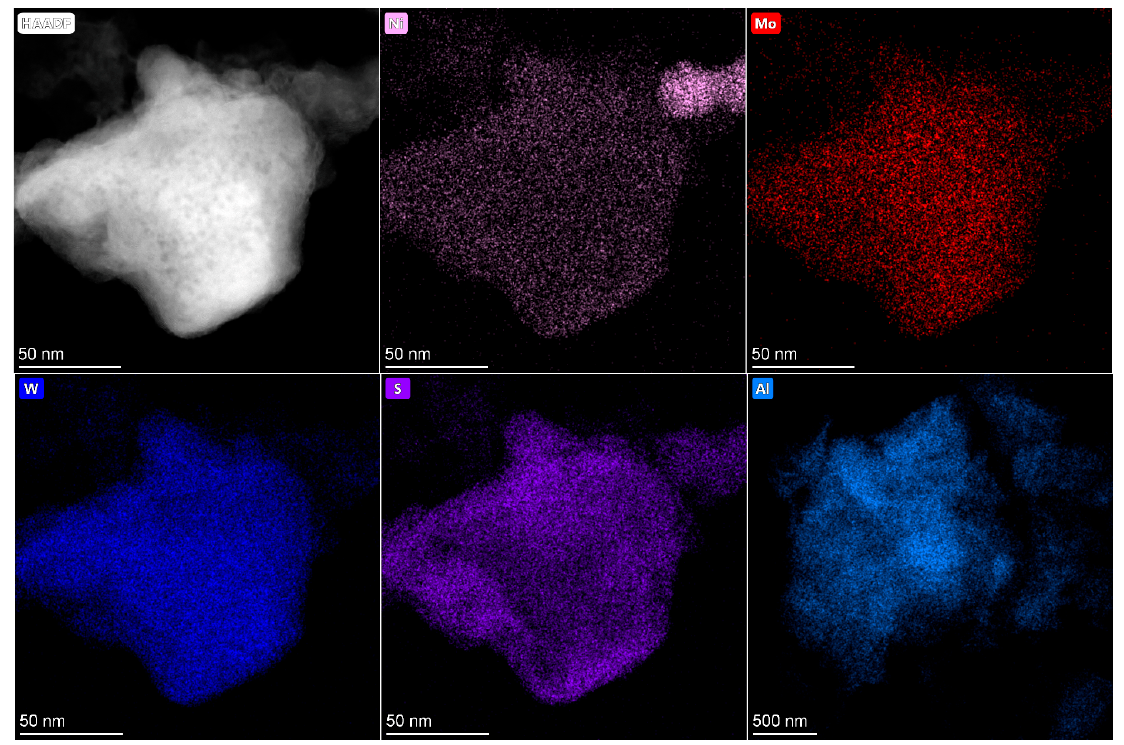
Figure 7. HAADF data on the c—Ni 1 Mo 0.5 W 0.5 sulfide catalyst after testing.